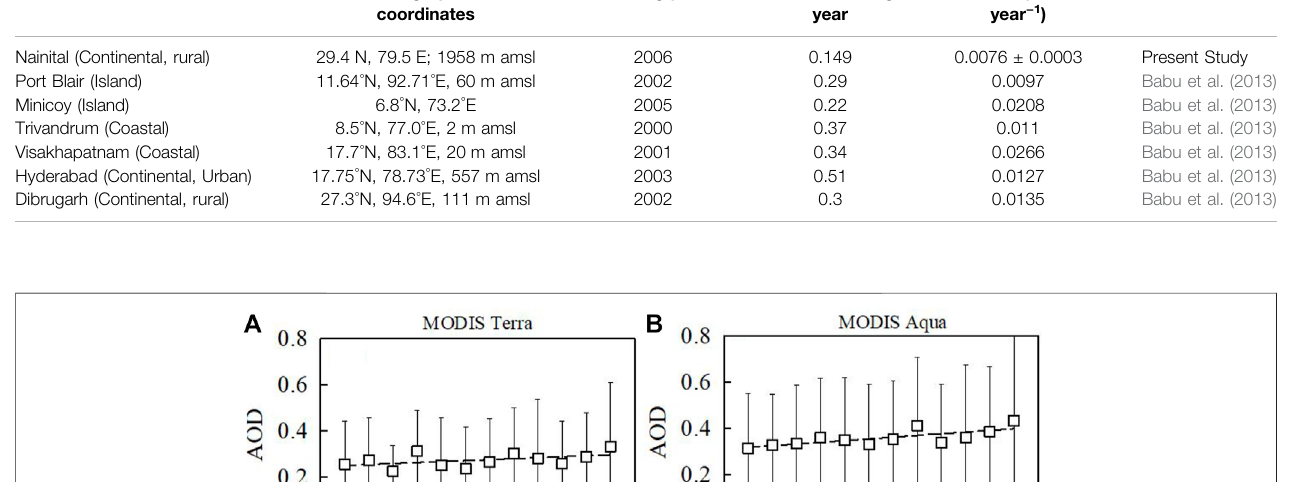
Frontiers in Earth Science |